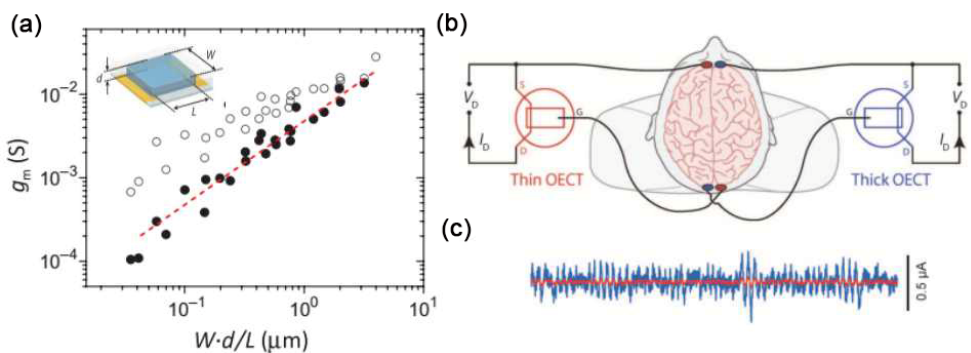
Figure 3. ( a ) The relationship between OECT transconductance ( g m ) and channel geometry ( W ·d/L). ( b ) Human electroencephalography recordings with thin OECT (red) and thick OECT (blue). ( c ) Electroencephalography signals recorded by the two OECTs, thin OECT (red) and thick OECT (blue). Figure reproduced with permission from reference [30].